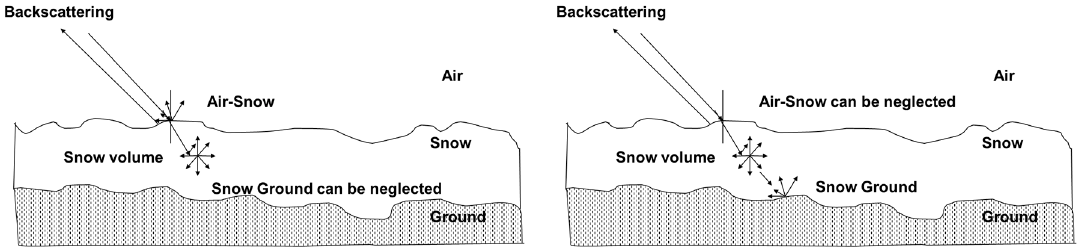
Figure 1. Microwave scattering mechanisms for wet ( left ) and dry ( right ) snowpacks. (After Shi and Dozier,